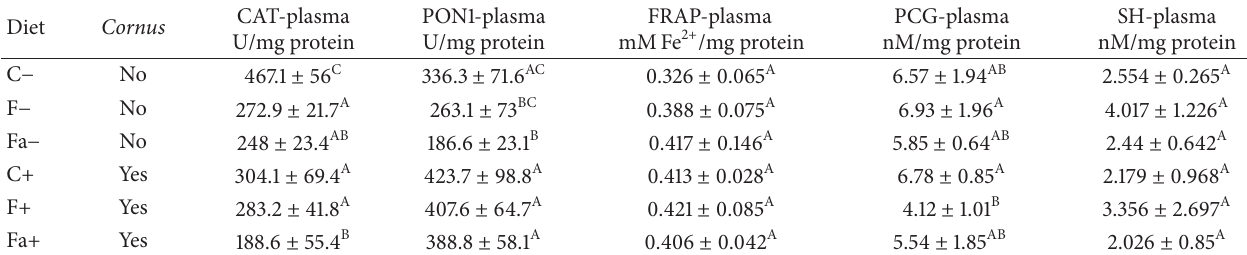
Table 3: Activity of oxidative stress markers (CAT, PON1, FRAP, PCG, and SH) marked in plasma in Wistar rats. Data are presented as means from independent measurements ± standard deviation (SD). Different letters in the same columns indicate significant differences according to Tukey’s test ( 𝑃 < 0.05